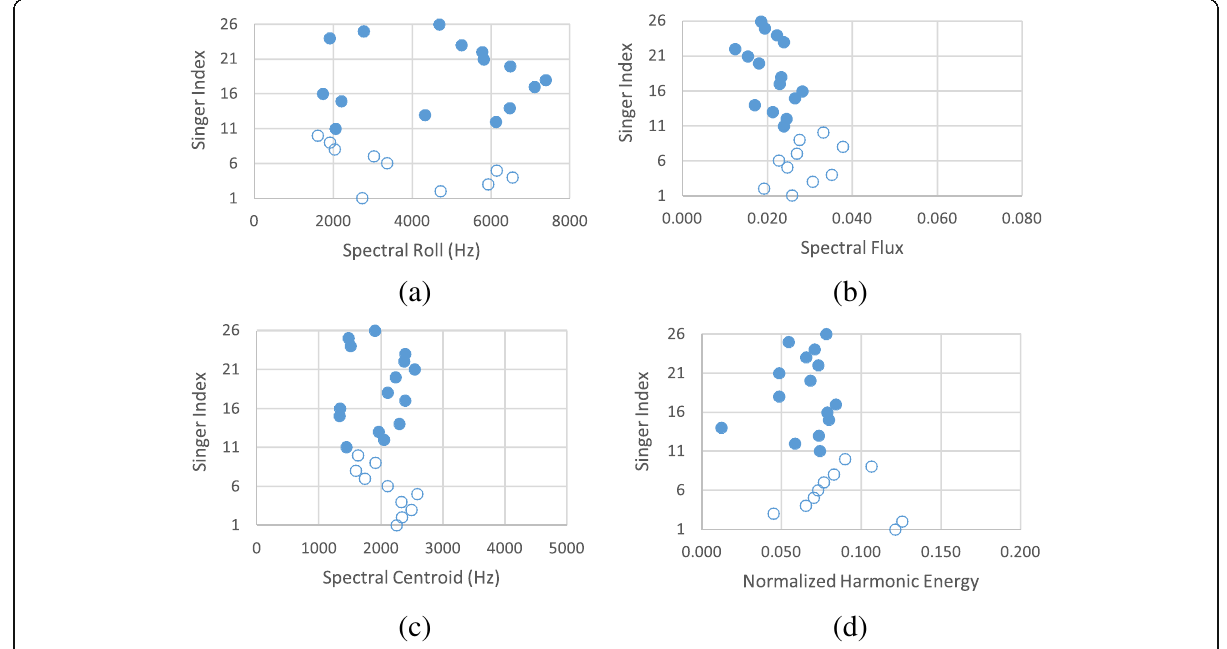
Fig. 3 a – d Analysis of spectral timbre features for each singer (blue circle indicates male singer; white circle indicates female